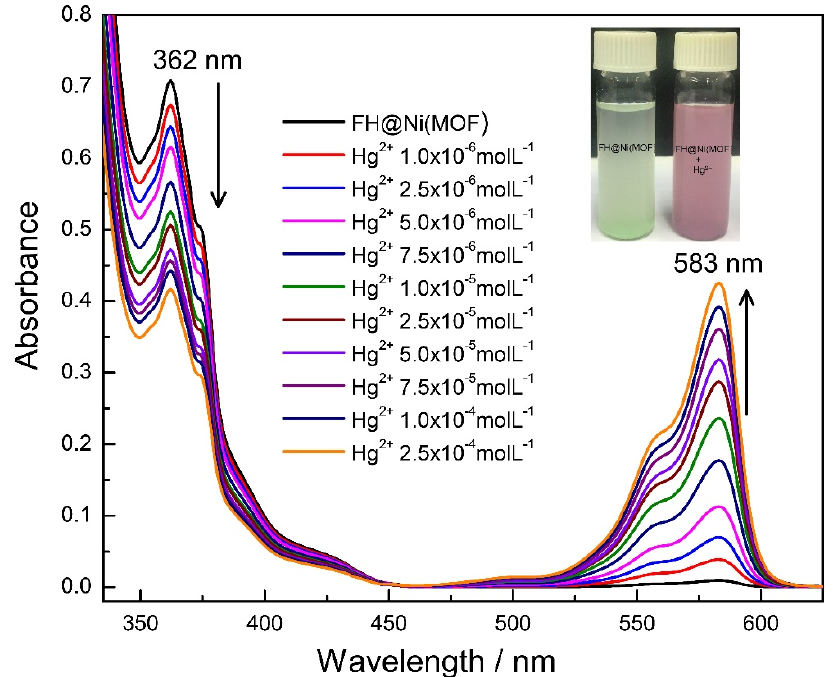
Figure 5. Changes in the UV–vis spectra of FH@Ni(MOF) with the incremental addition of Hg 2+ (10 − 2 M) in water. Inset: change in the color of FH@Ni(MOF) upon the addition of Hg 2+ .